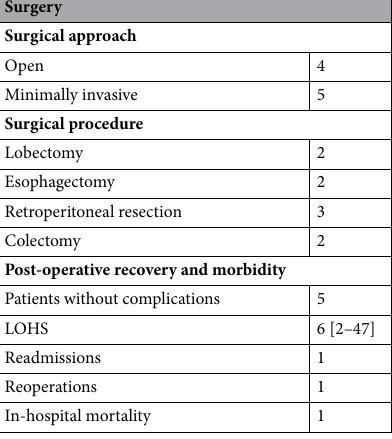
Table 4. Surgical and post-operative outcomes. Data are presented as n: absolute number of patients, or median